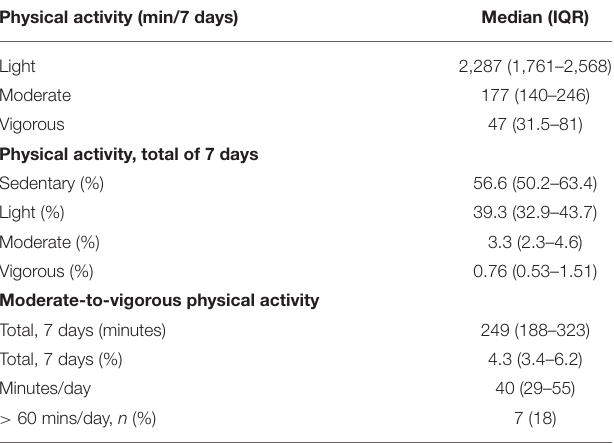
TABLE 2 | Physical activity levels of all patients.